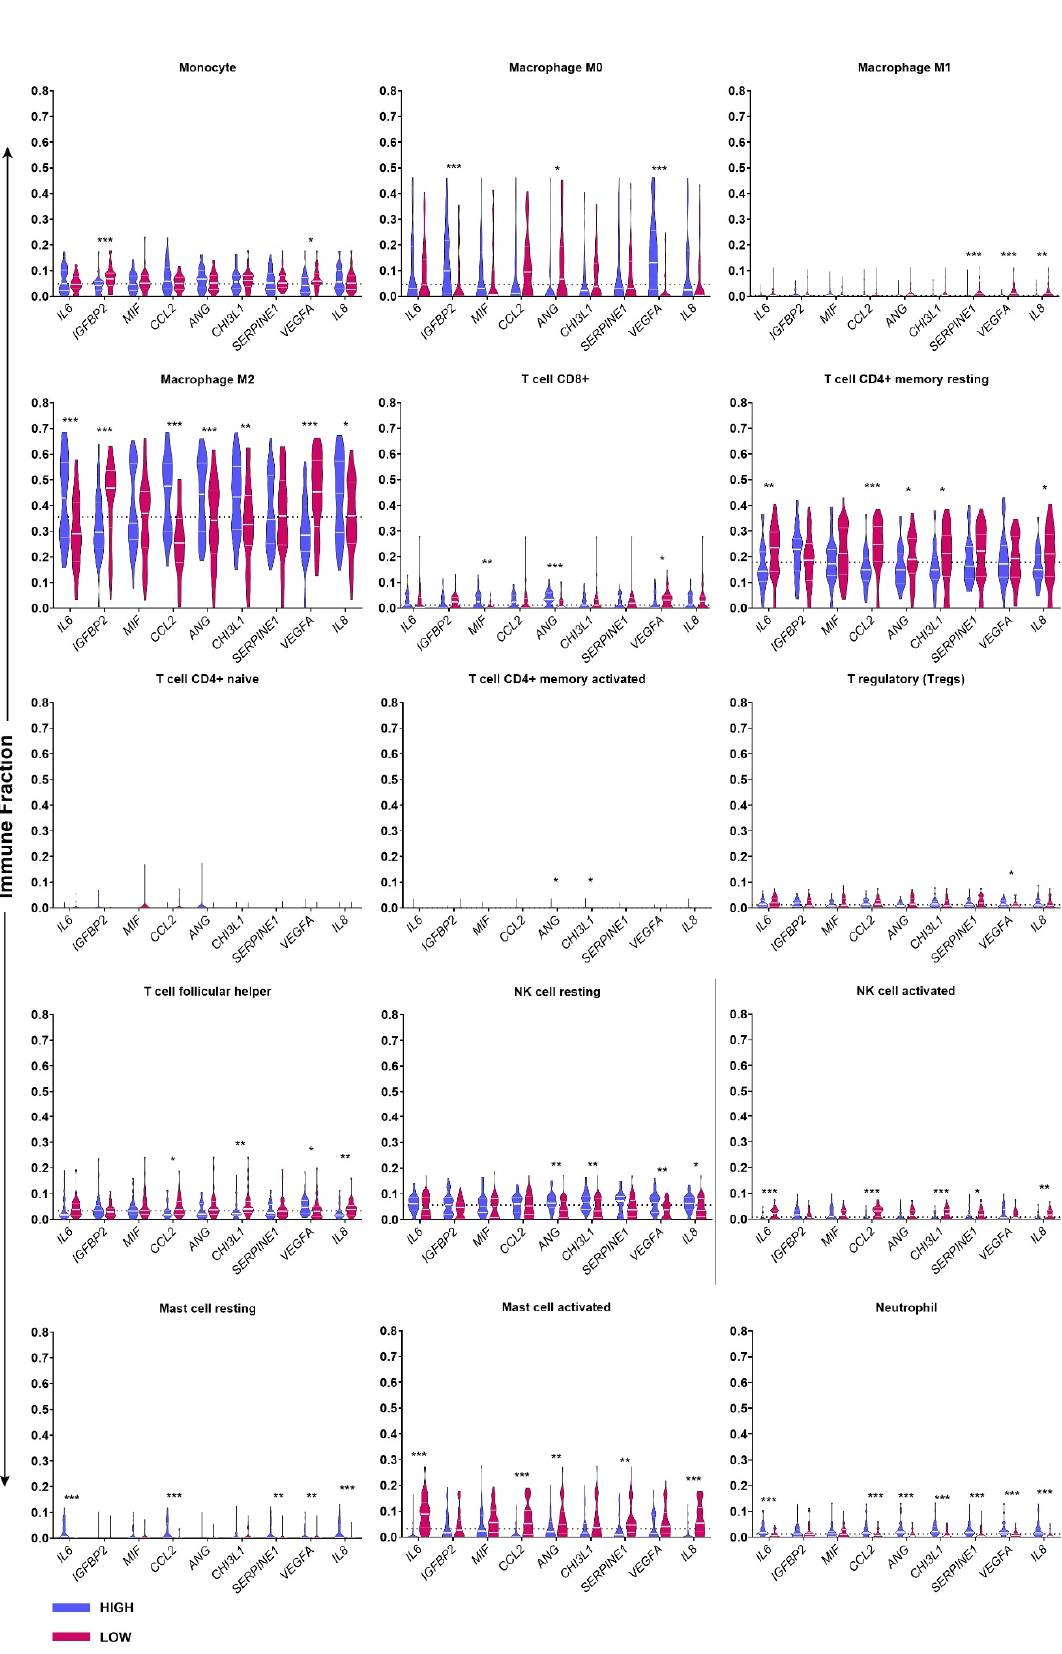
Figure 7. Violin plots of TCGA GBM RNA-seq CIBERSORT immune subset deconvolution. CIBER- SORT immune subset deconvolution was applied to 160 publicly available GBM RNA-seq dataset. Data were separated into quartiles to define high expressing samples (Q1) (n = 40) from low express- ing samples (Q4) (n = 40) for IL6 , IGFBP2 , MIF , ANG , CHI3L1 , SERPINE1 , VEGFA , and IL8 . Data